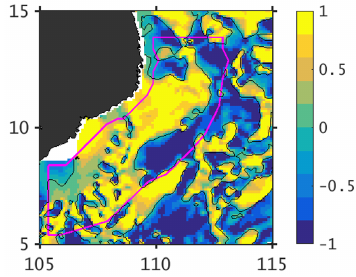
Figure B1. Example of modeled SI in August 2010.